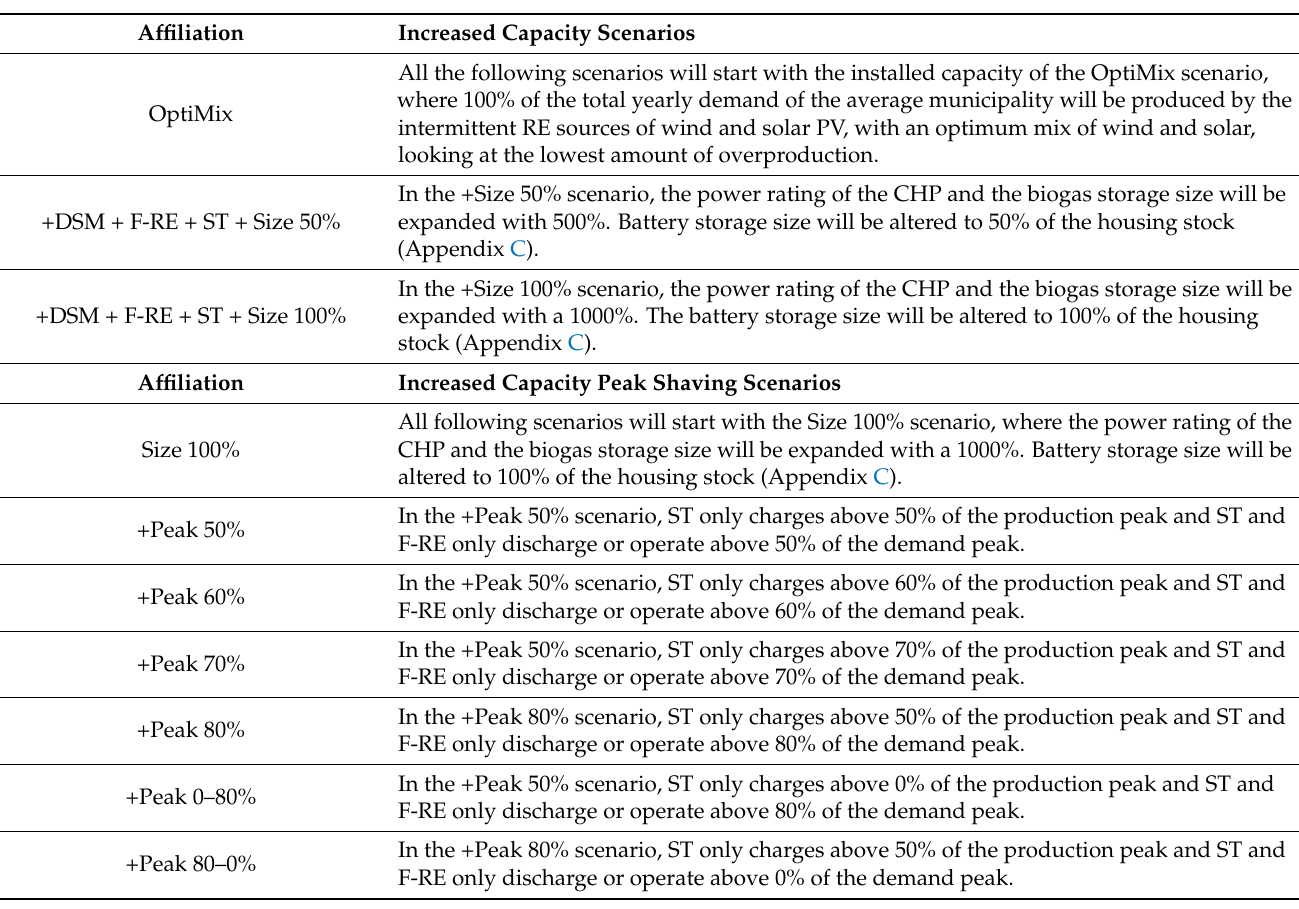
Table A17. Increased capacity of balancing technology scenarios including peak shaving.